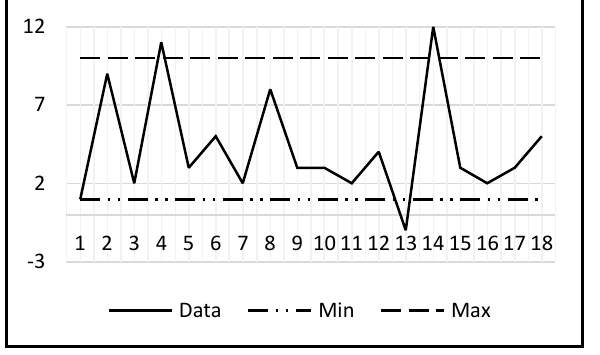
Figure 2 (b). Filtered data stream.